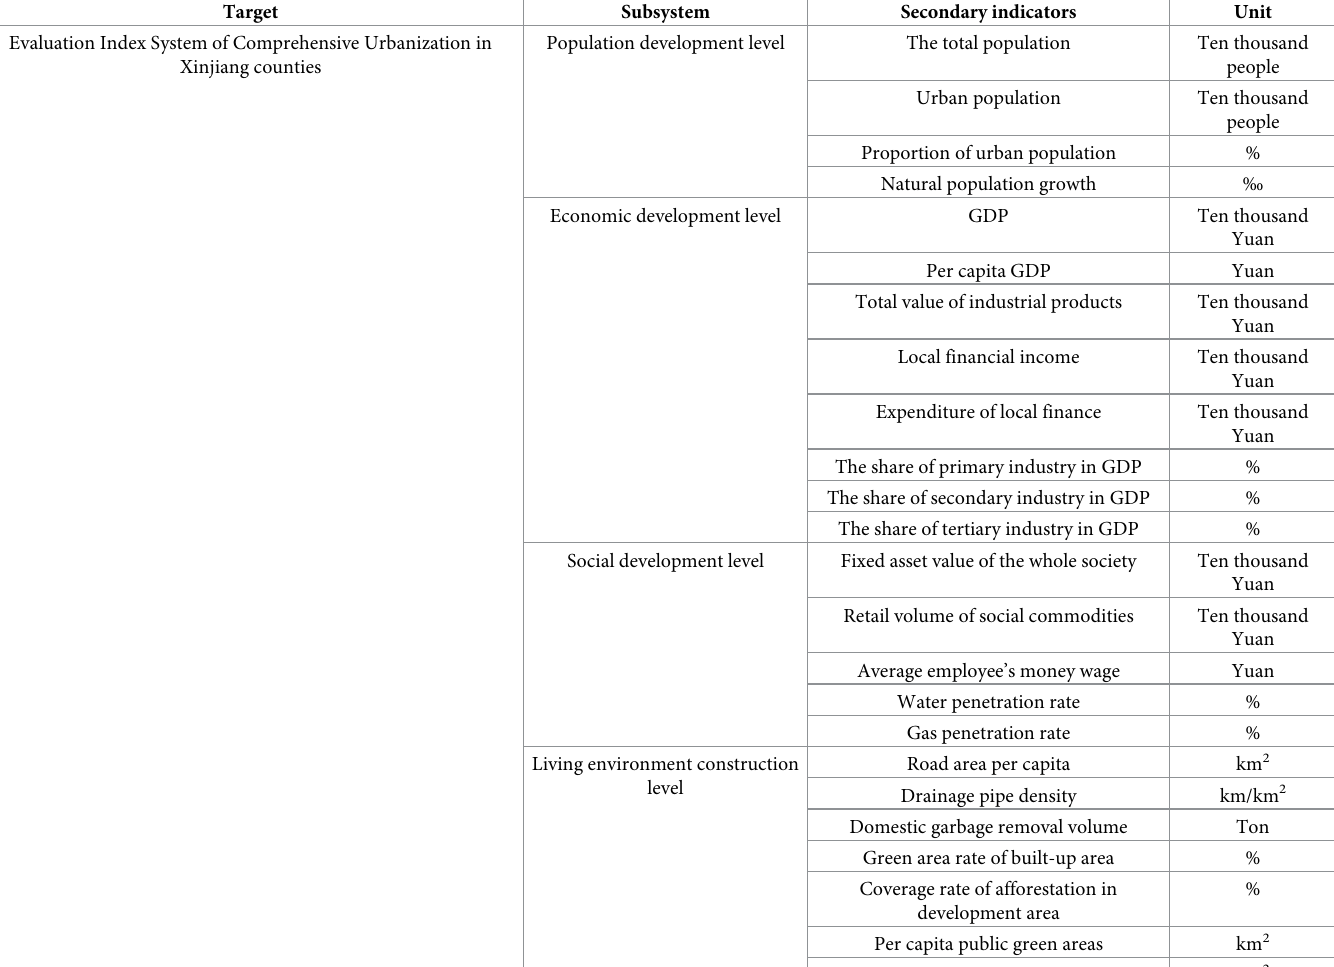
Table 1. Indicator